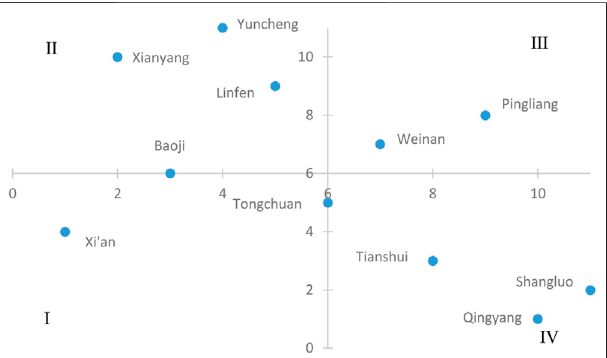
FIGURE 6 | Comprehensive ranking diagram of new-type urbanization quality and ecological environment quality